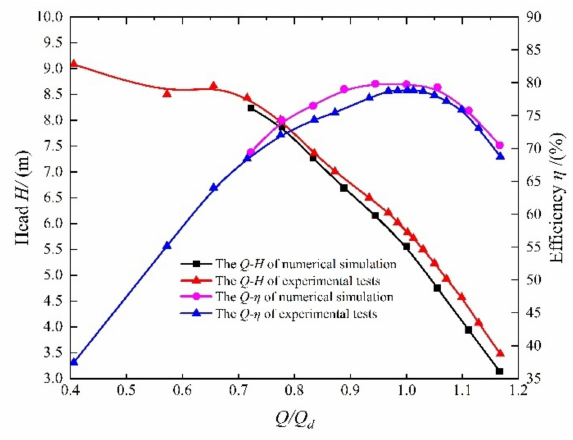
Figure 21. Performance curve